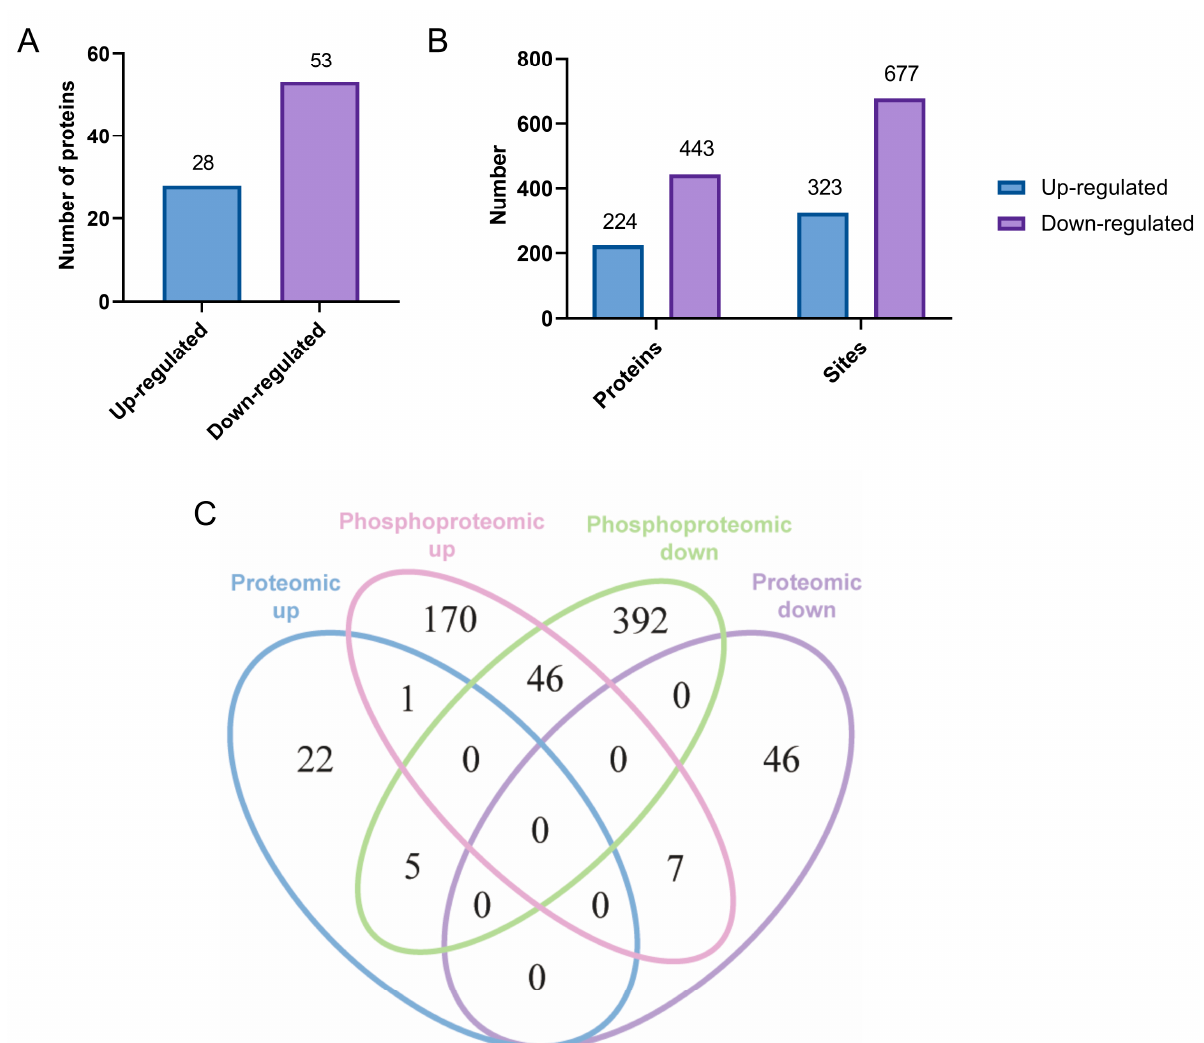
Figure 2. Summary of proteomics and phosphoproteomics data. ( A ) Statistical analysis of differentially expressed proteins in proteomics. ( B ) Statistics of differentially expressed phosphorylated proteins and corresponding peptides in phosphoproteomics. ( C ) Venn diagrams of differentially expressed proteins and differentially phosphorylated proteins were identified in the two omics analyses.